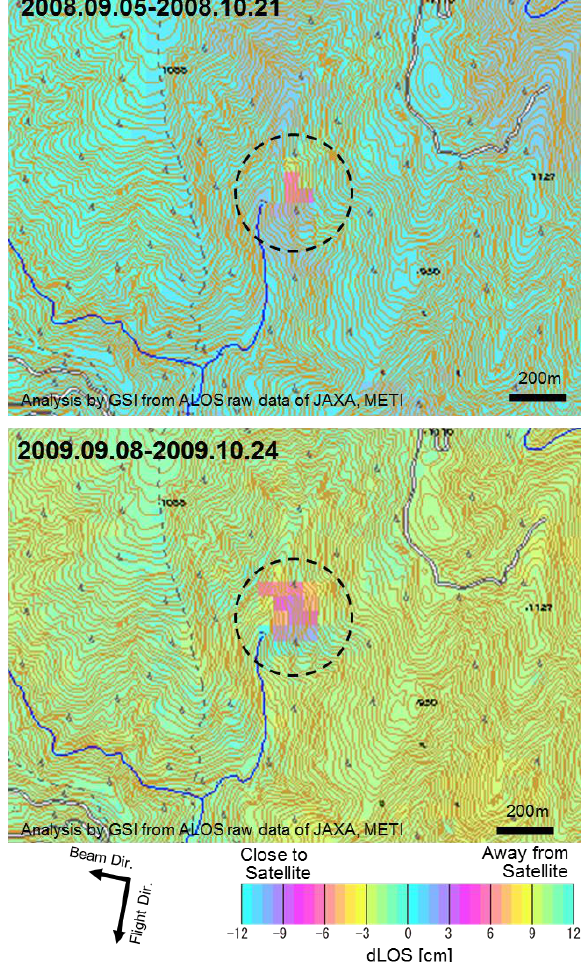
Figure 2. InSAR imageries on GSI Maps in Shizuoka site. Upper figure is InSAR imagery between September 5, 2008 September 8, 2009 and October 24,